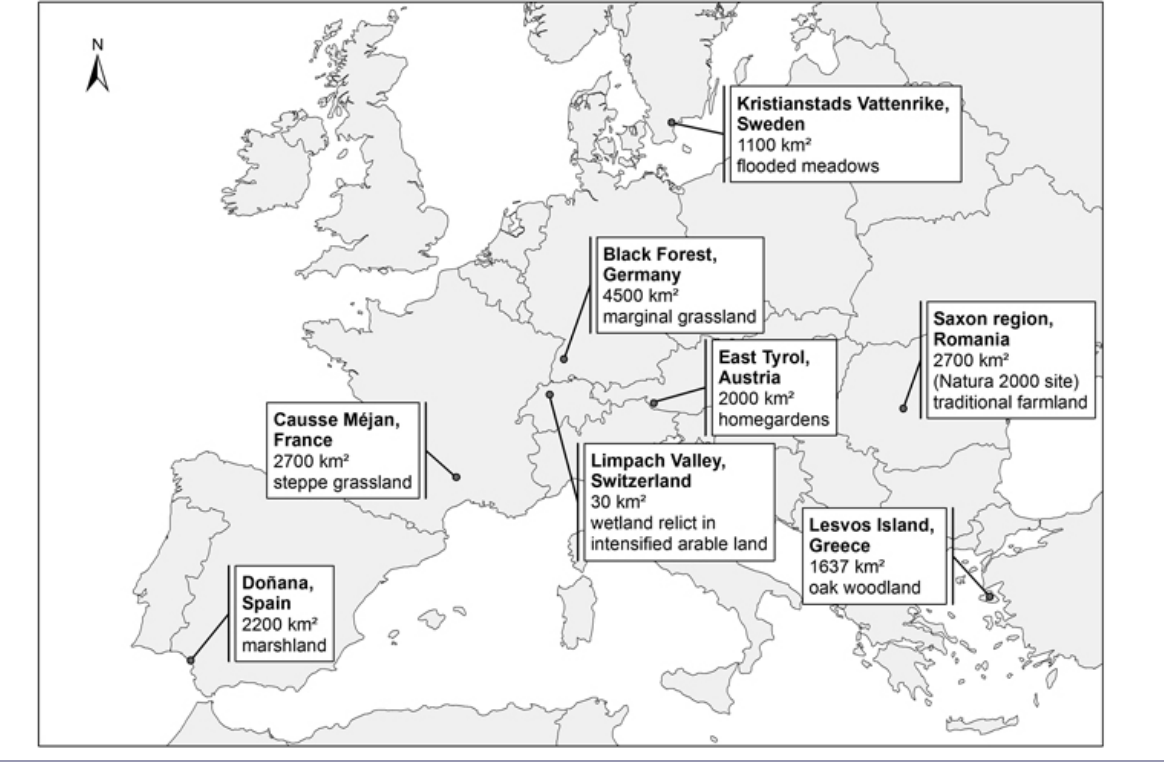
Fig. 1 . HNV (high-nature-value) farmlands considered as case studies in this review. Boxes indicate study area, country, extent, and ecological systems in focus.